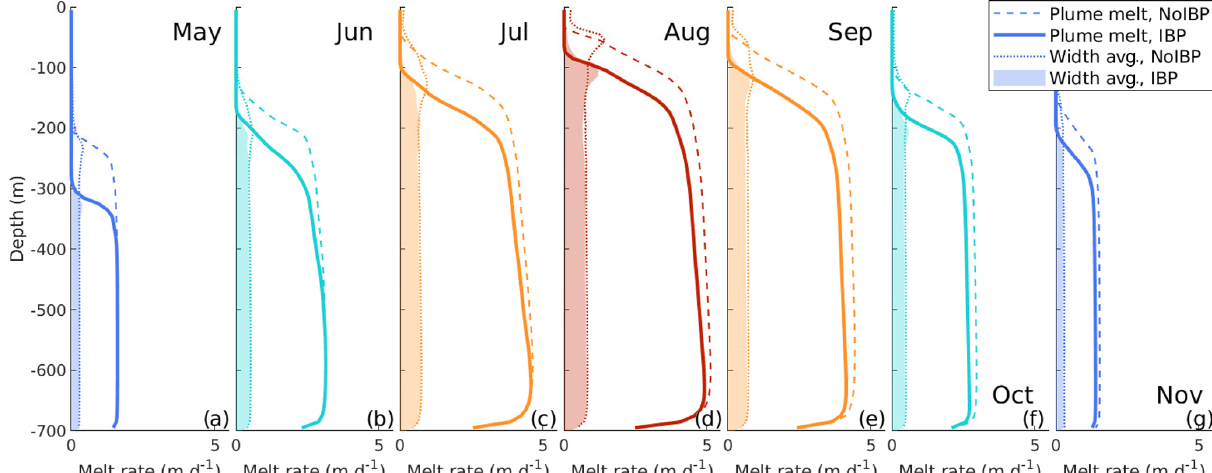
Figure 5. Seasonality of the plume melt rate and width-averaged frontal melt rate throughout the runoff season for both NoIBP (dashed line, dotted line) and IBP (solid line, shaded area).